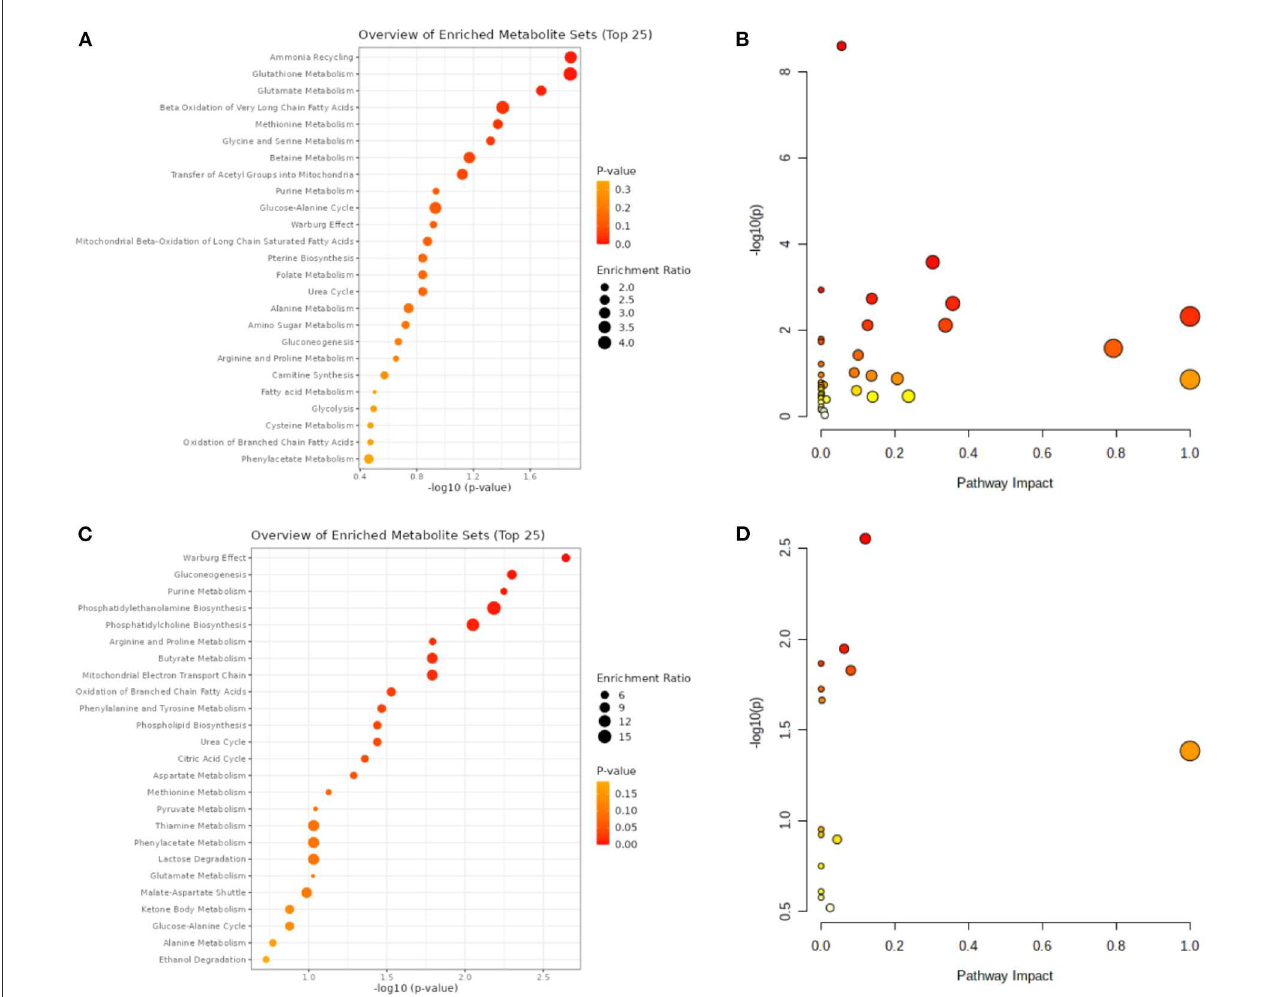
FIGURE1 VCI and HCC metabolomic analysis. (A) VCI differentially expressed metabolite enrichment analysis diagram; (B) Differentially expressed metabolite signaling pathways in VCI; (C) Differentially expressed metabolite enrichment distributions in HCC; (D) Differentially expressed metabolite signaling pathways in